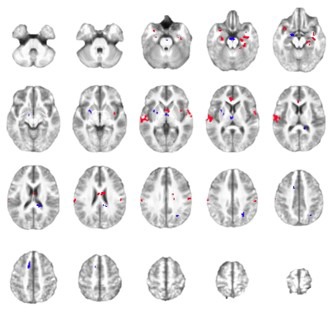
Common effects of stimulation across sites.Regions showing a significant main effect of stimulation condition, regardless of demand or stimulation site. Left = Left. Red coloration indicates supra-threshold voxels with positive differences (stimulation >sham) and blue coloration indicates negative differences (sham > stimulation).